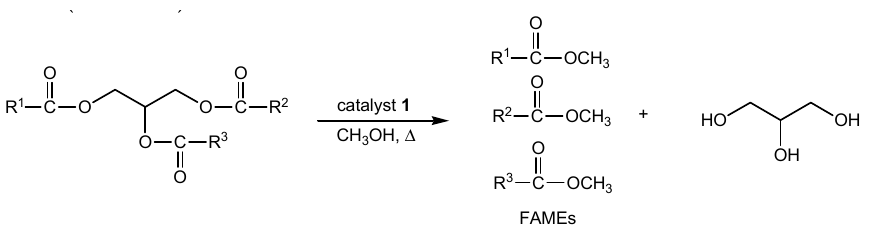
Figure 3 . ATR − FTIR spectrum of catalyst 1 ( A ) as-prepared, ( B ) after fourth cycle, and ( C ) after fourth cycle and thermal treatment at 400 °C.